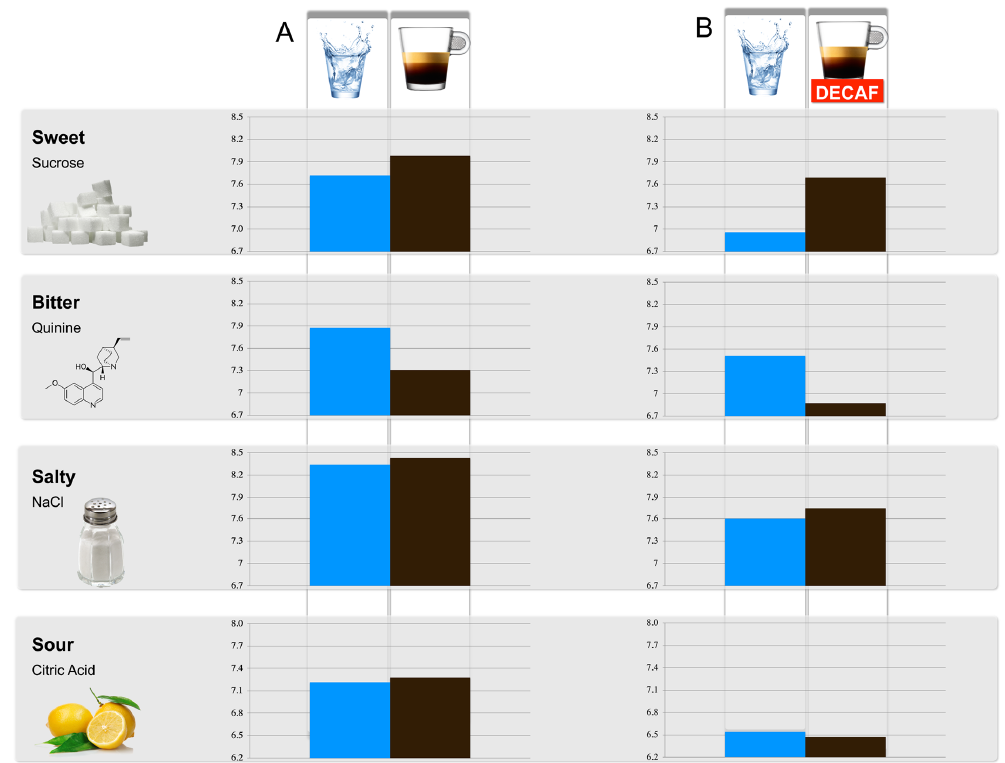
Figure 1. Tastant detection thresholds (dilution steps 1–10). ( A ): testing after water consumption and regular co ff ee consumption. ( B ): testing after water consumption and deca ff einated co ff ee consumption (DECAF: deca ff einated co ff